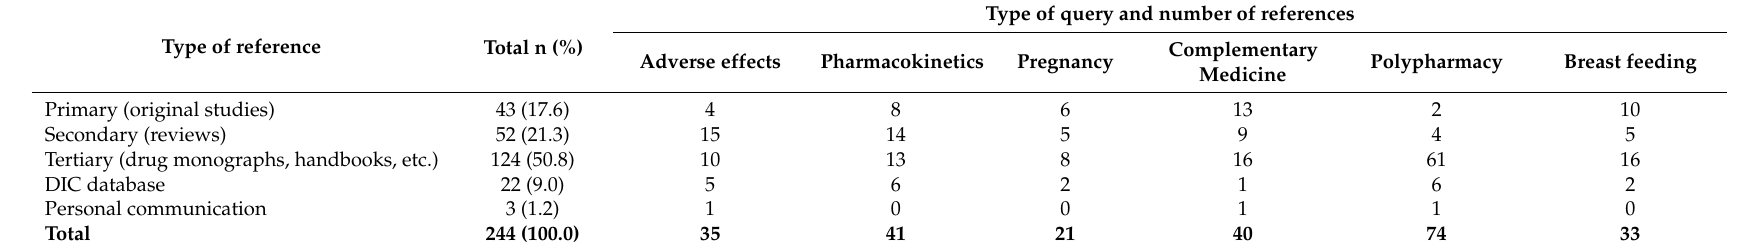
Table 2. Type of reference related to type of query for the seven Scandinavian drug information centres (DICs) participating in the study.